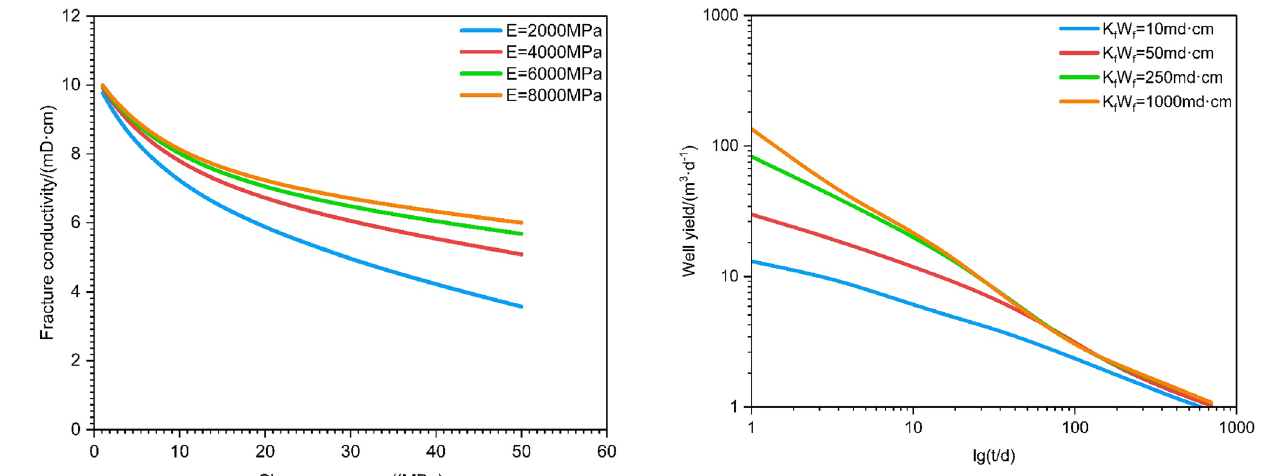
Fig. 7 Variation curves of fracture conductivity under different clo- sure pressures